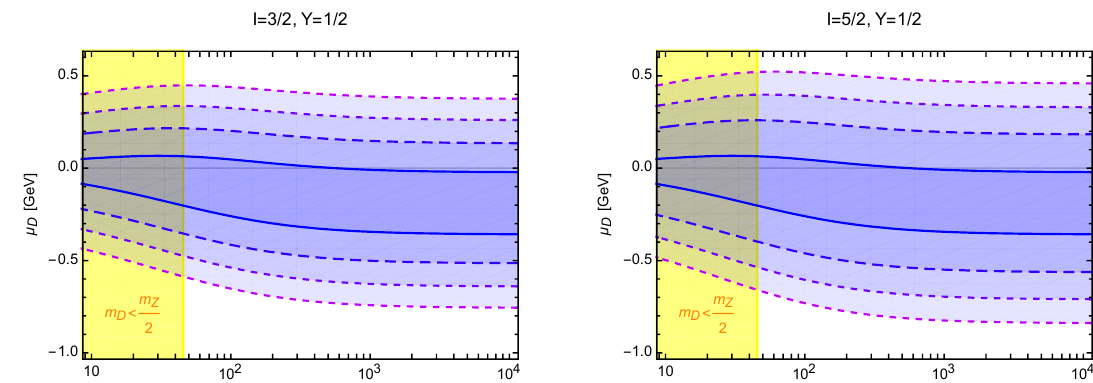
= 0 , 0 . 1 , 0 . 2 , 0 . 3 GeV. M